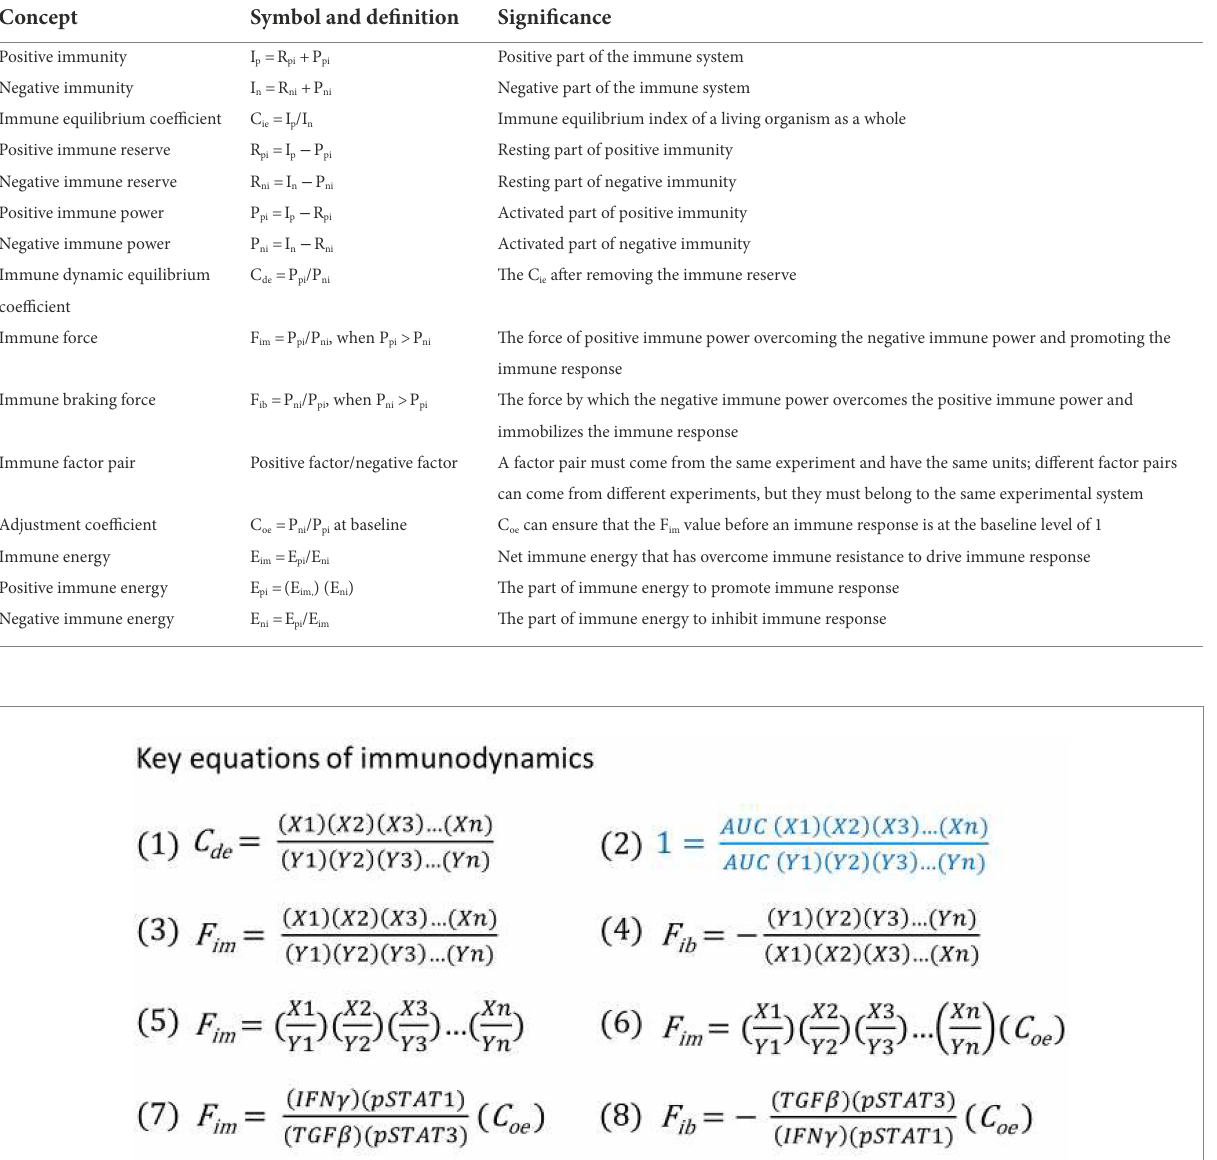
TABLE 1 Key concepts of